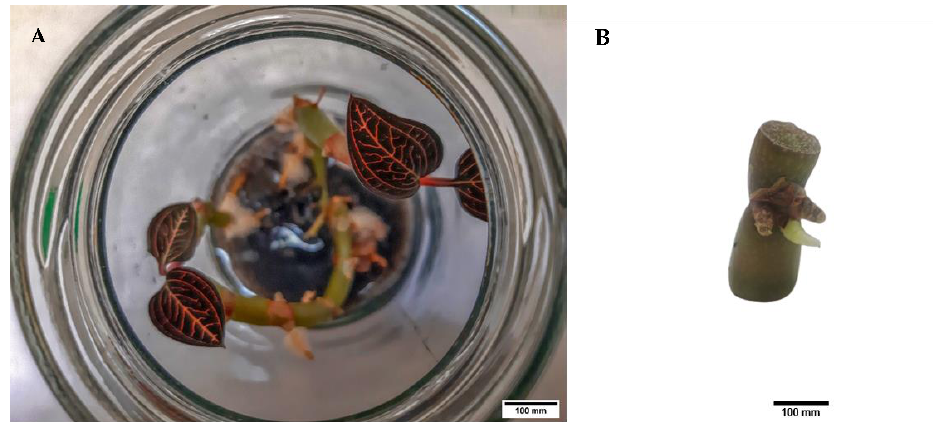
Figure 9. ( A ) In vitro stock culture of L. discolor propagated from nodal segments and ( B ) excised node with axillary bud present.